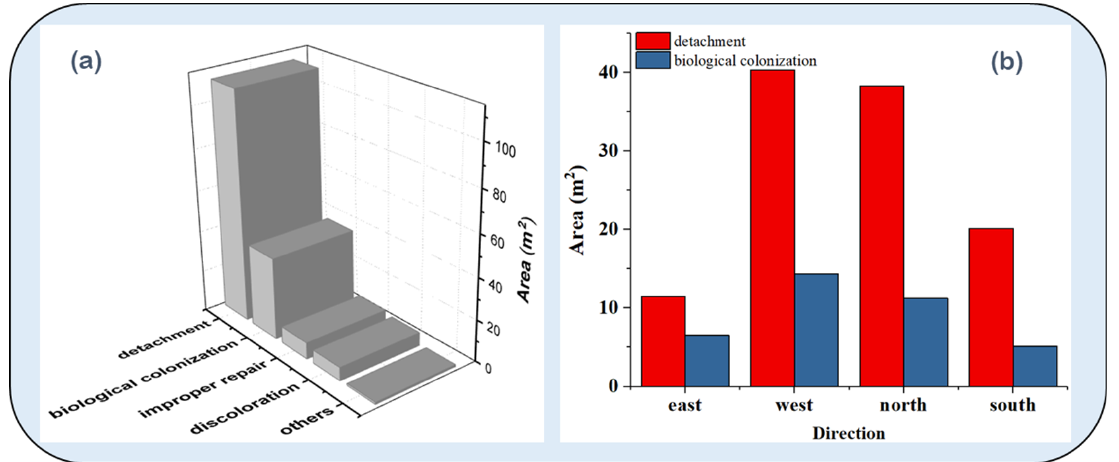
Figure 5. Types and scales of weathering diseases of the stone house. ( a ) demonstrates the types of weathering diseases; ( b ) shows the weathering areas of the stone house in different directions.